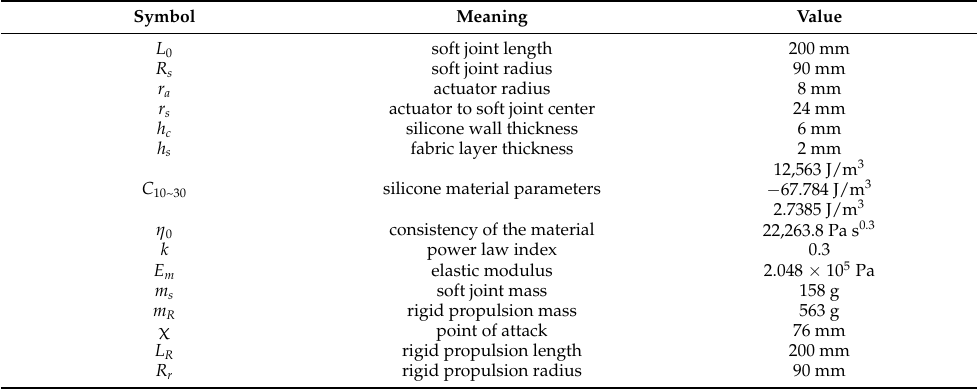
Table 1. Design parameters of the prototype snake